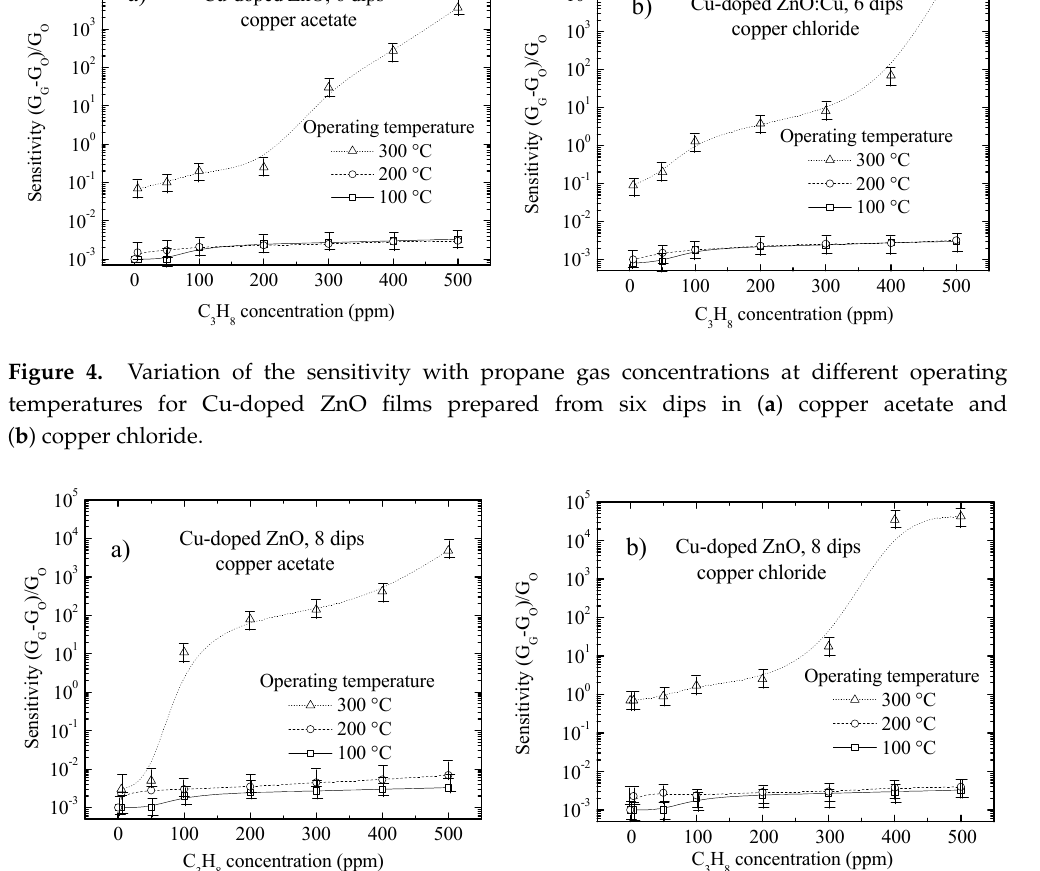
Table 2. Number of dips and corresponding film thicknesses. Film